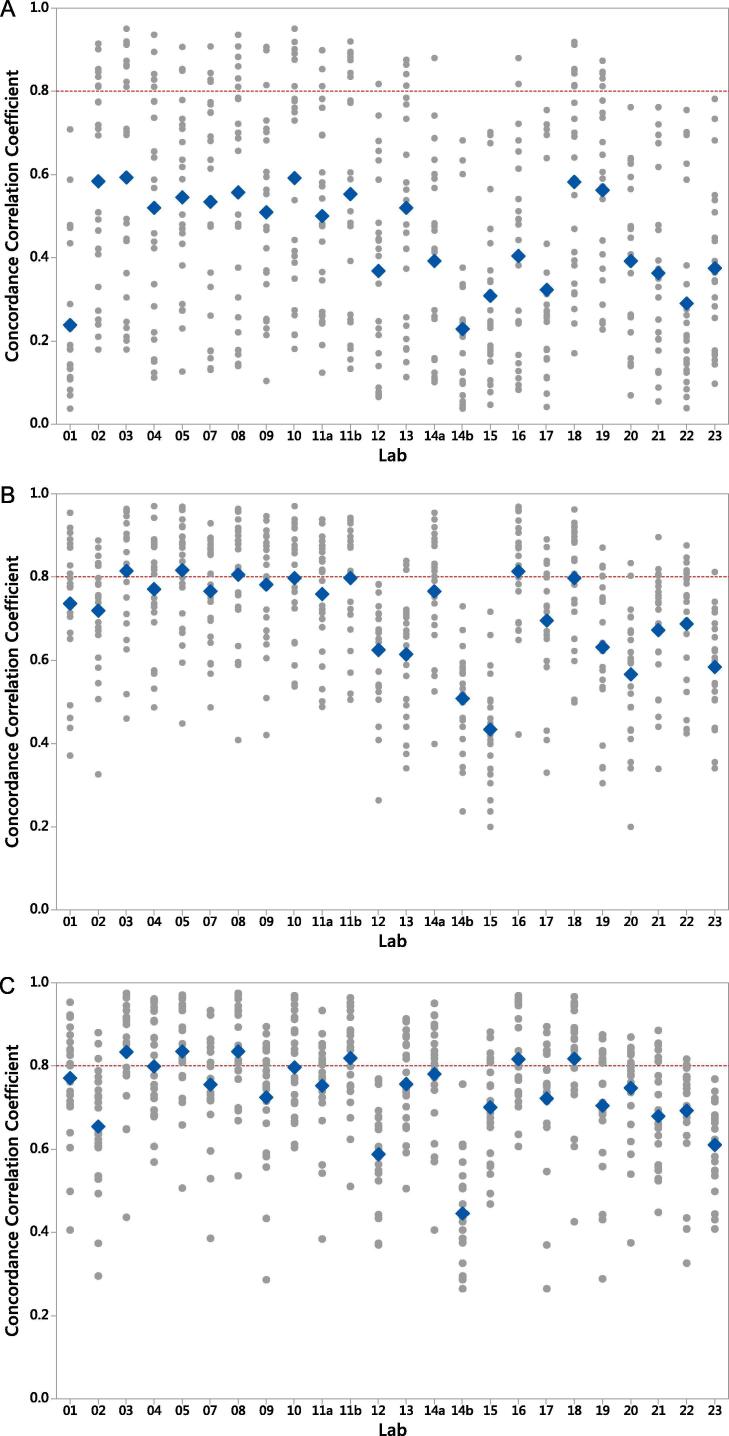
Concordance Correlation Coefficients. Concordance correlation coefficients for the human samples only (A), log potencies relative to 16/284 (B), and log potencies relative to 16/322 (C). Red line indicates threshold of “poor” concordance correlation coefficients <0.8. Blue diamond indicates mean concordance correlation coefficient.